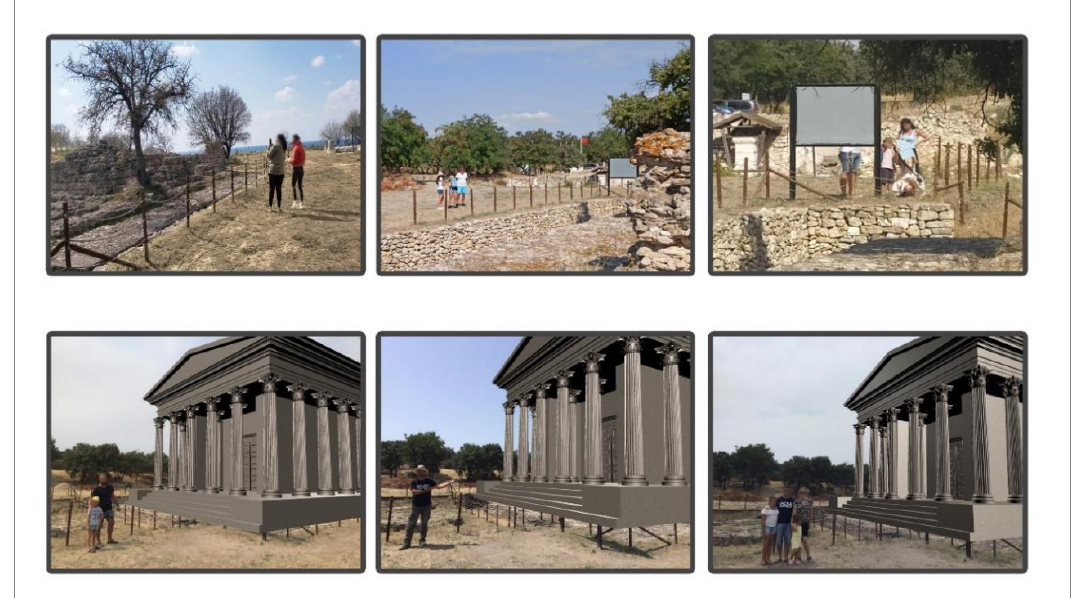
Figure 15 Visitor